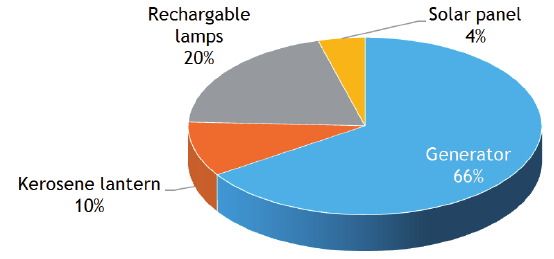
Fig. 2 - Alternate sources of power. Source: Survey data, 2014.